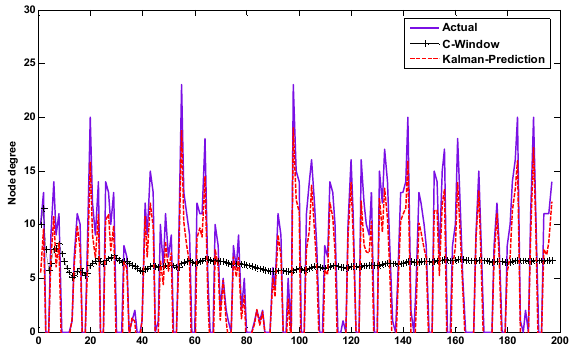
Figure 7. Node degree values of an illustrative Reality hub node in a certain time window, comparing the actual value, the Kalman prediction, and the C-Window estimate. Kalman prediction clearly outperforms C-Window when estimating the actual node’s degree level in each time window, and it captures the periodic pattern of the node degree quite